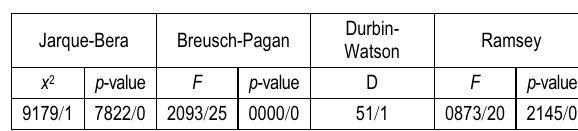
Table 4. Test results of the statistical assumptions